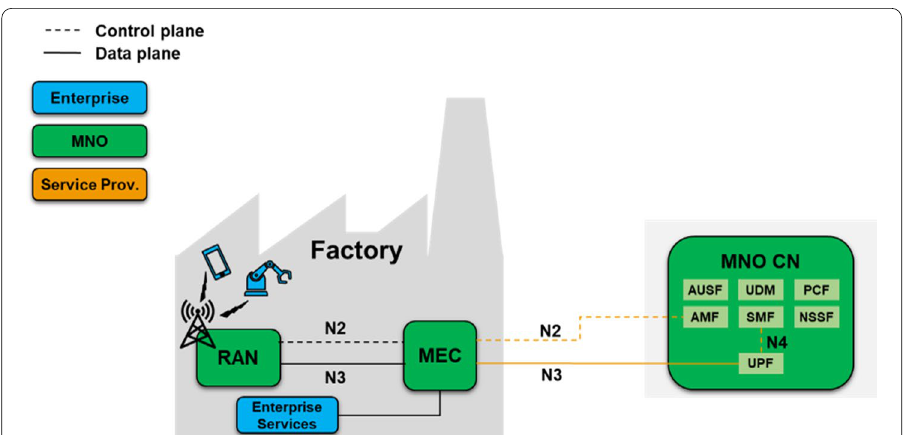
Fig. 12 MNO’s Private Core Network architecture bump‑in‑the‑wire edge breakout